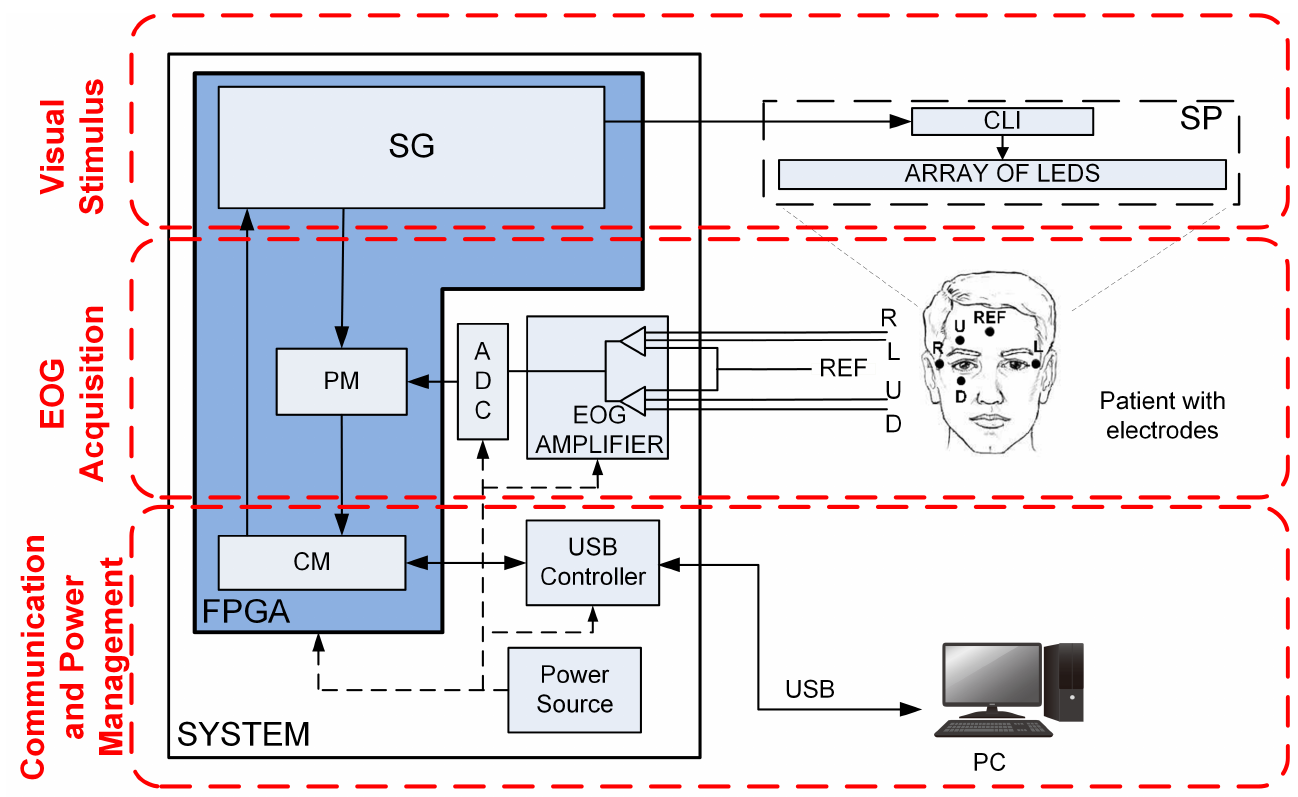
Figure 6. Blocks outline of the general